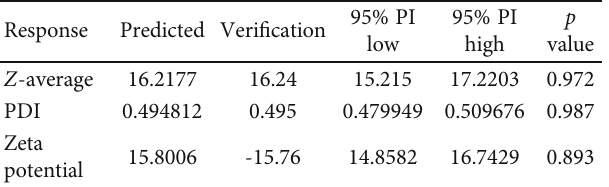
Figure 4: The optimum formulation from Design Expert 12® program. Table 5: Predicted and veri fi cation value of Z -average, PDI, and zeta potential.